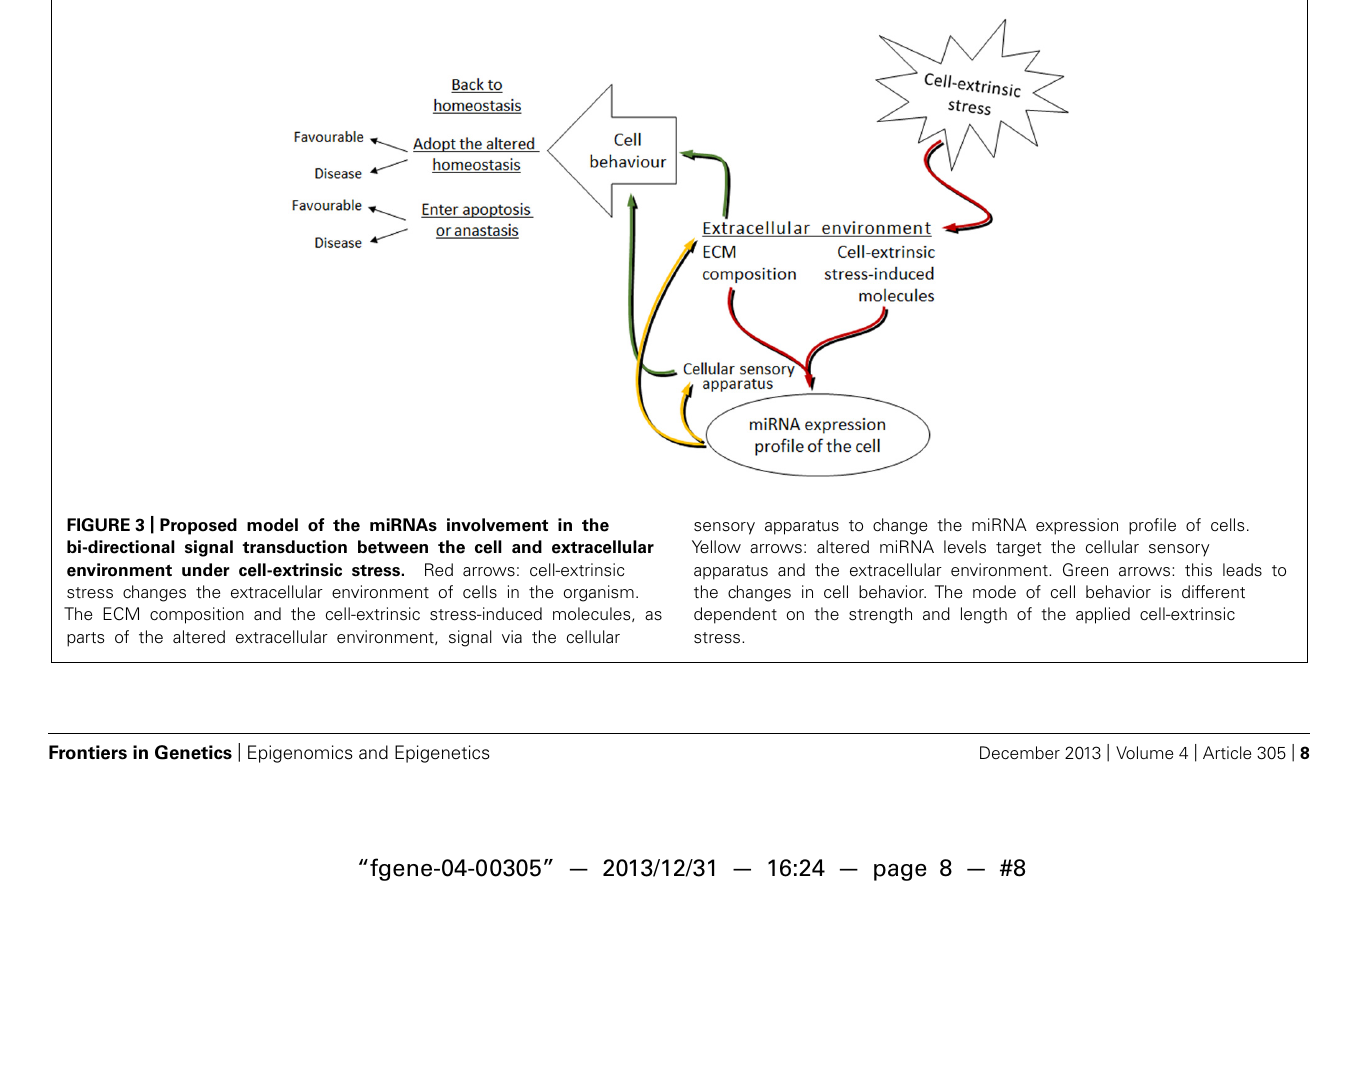
FIGURE 3 | Proposed model of the miRNAs involvement in the bi-directional signal transduction between the cell and extracellular environment under cell-extrinsic stress. Red arrows: cell-extrinsic stress changes the extracellular environment of cells in the organism. The ECM composition and the cell-extrinsic stress-induced molecules, as parts of the altered extracellular environment, signal via the cellular